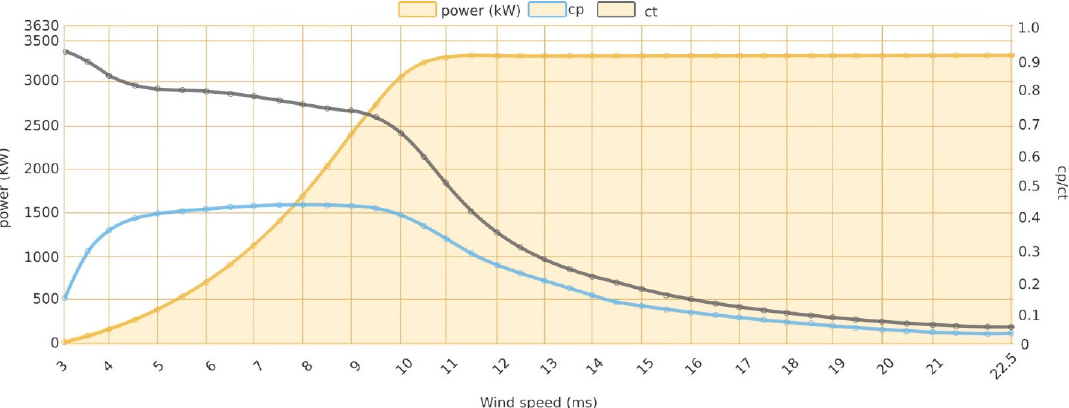
Figure 17. Power curve of the Vestas V126-3.3 MW wind turbine. Source: [15].